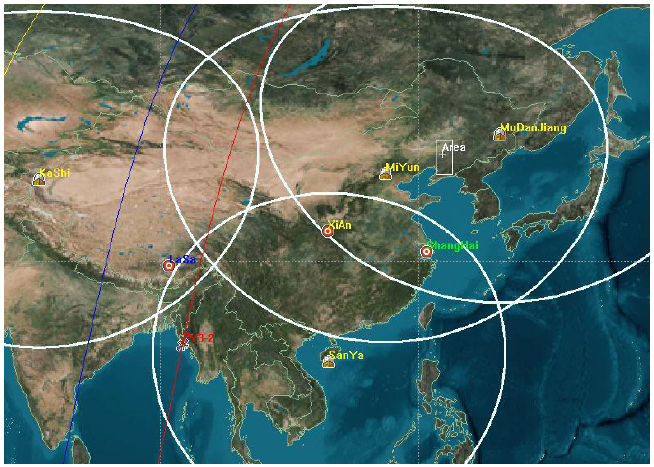
Figure 3. Schematic diagram of resource satellite’s access to regional targets.